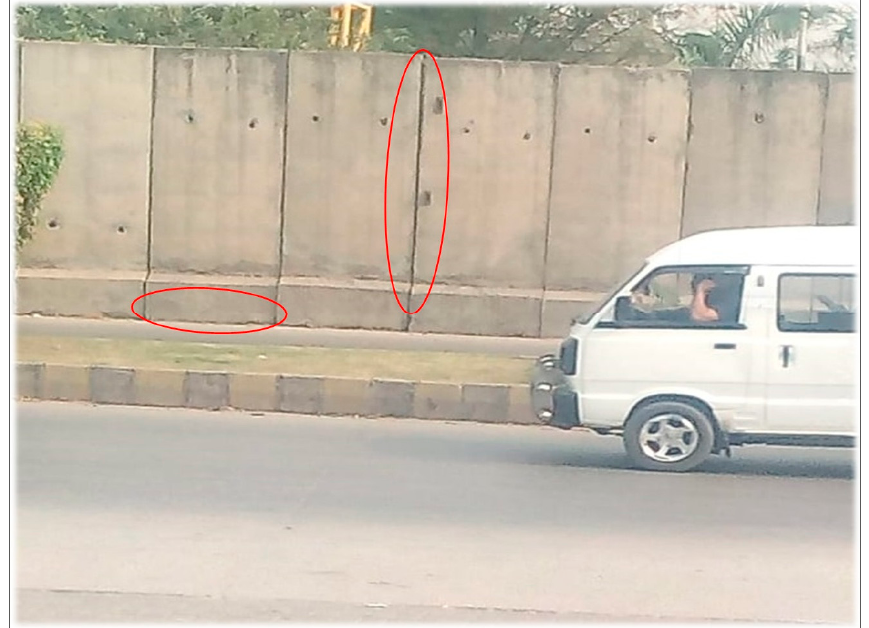
Figure 5. Weaknesses observed in existing arrangements.